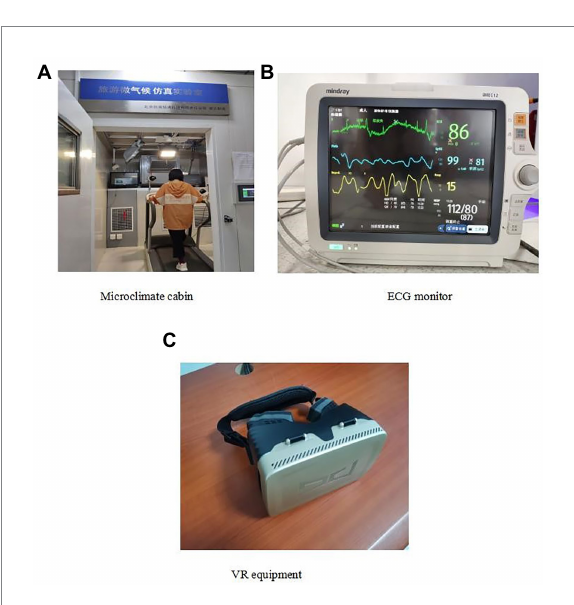
FIGURE 2 Experimental facilities ( A : Microclimate cabin; B : ECG monitor; C : VR equipment). Images reproduced with the permission of Zhang